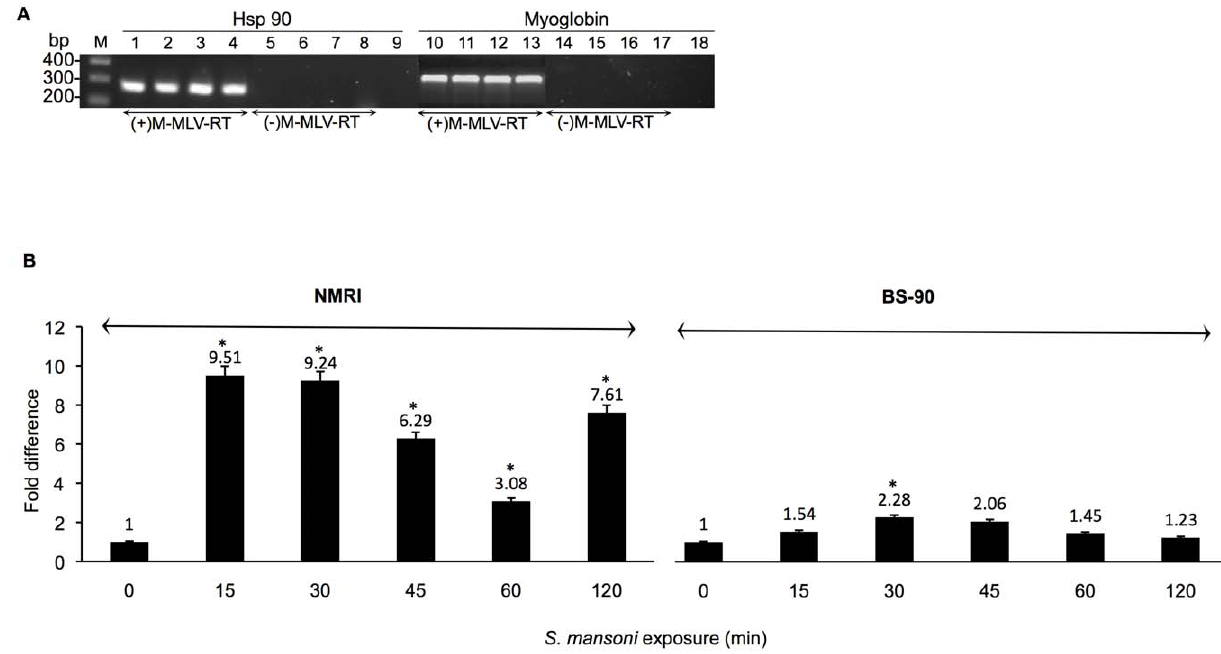
Figure 1. Expression of the Hsp 90 transcript in resistant BS-90, and susceptible NMRI juvenile snails, without and with parasite exposure. ( A ) Constitutive expression of Hsp 90 and myoglobin in two juvenile BS-90 (lanes 1, 2, 5, 6, 10, 11, 14 and 15) and NMRI (lanes 3, 4, 7, 8, 12, 13, 16 and 17) snails by qualitative RT-PCR, using cDNA synthesized with [ + M-MLV-RT], or without [ 2 M-MLV-RT] RT in the first strand reaction. The same cDNA template was utilized for PCR amplification but with gene specific primers (forward and reverse) corresponding to the specific transcripts. Amplified bands of the expected size, 199 bp for Hsp 90, and 350 bp for myoglobin stained by ethidium bromide after agarose gel electrophoresis are shown. PCR amplification conducted without cDNA template is shown in lanes 9 and 18. The 100 bp ladder run in parallel is shown on the left. ( B ) Analysis of the fold difference in Hsp 90 expression by real time qPCR between NMRI and BS-90 snails either without (0) S. mansoni miracidia exposure or after different time points (15 to 120 mins) PE. The histograms in 1B represent pooled data from 5 independent experiments, each performed with RNA (assayed in triplicate) isolated from 10 individual size-matched juvenile snails. The asterisk * indicates statistical significant P- values of , 0.05 by using